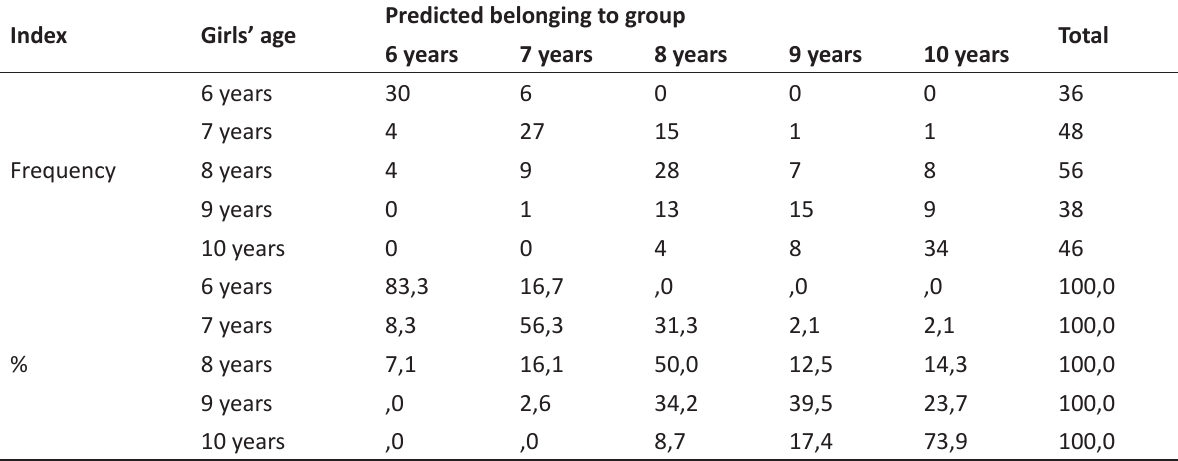
Table 3. Results of groups’ classification. 6–10 years old